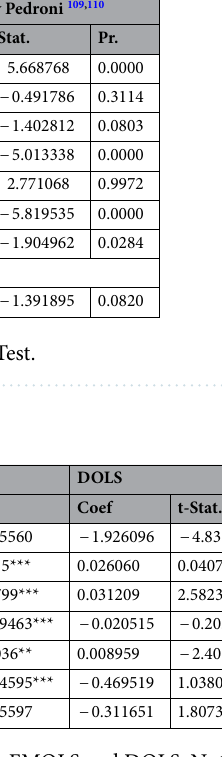
Table 6. Estimates using FMOLS and DOLS. Notes: The superscripts ***, ** & * signify statistical significant at the 1% , 5% and 10% respectively.